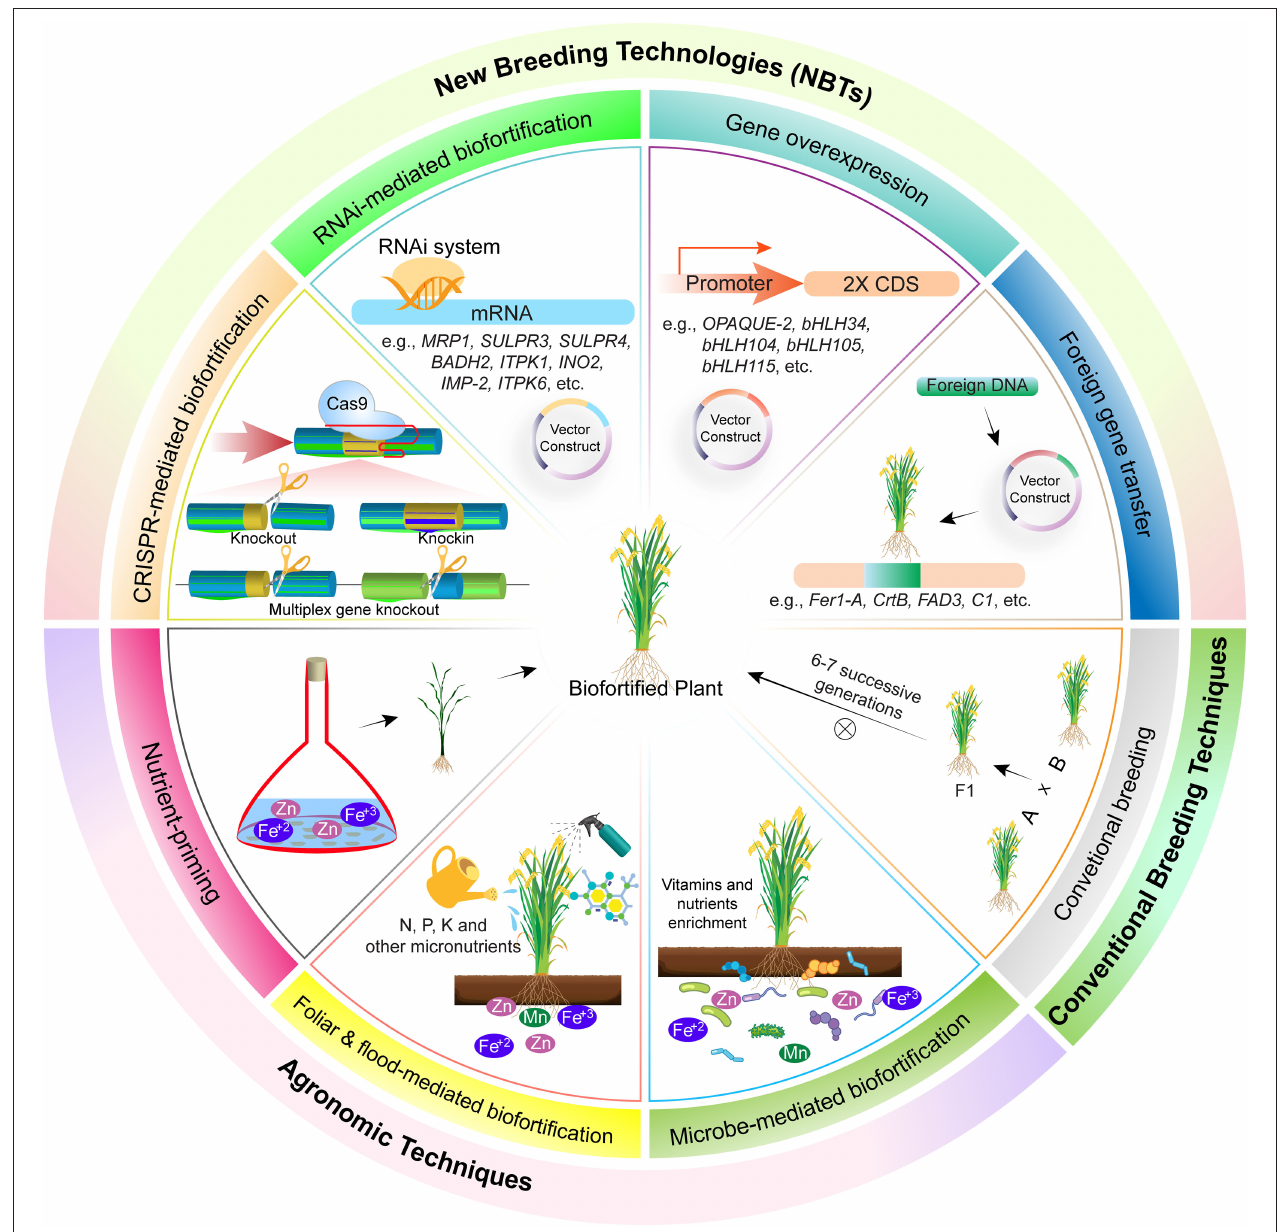
FIGURE 1 | Different methods for biofortification of crops. These are broadly classified into three types, i.e., agronomic techniques, biofortification of crops through foliar spray of micronutrients. Foliar application helps in acquisition of more nutrients in reproductive parts, and hence healthier foods are delivered to the consumer. In this technique, nutrients are applied in liquid form in aerial parts of plants and got absorbed through stomata and epidermis and become part of the food chain. Mineral fertilization through flooding for biofortification of crops. Minerals, i.e., selenium, zinc, calcium, etc., are supplied to crops alongside irrigation and are readily available for uptake and as a result their accumulation in eatable parts of plants is increased. Mineral fertilization through soil application for biofortification of crops. Mineral fertilizers, usually NPK, are applied in the soil bed before sowing or alongside seed using different seed cum fertilizer drills and as a result they are absorbed and made part of the food chain through root uptake. Microbe-mediated enhanced uptake of nutrients for biofortification of crops. Different microbial species, i.e., rhizobium bacteria, mycorrhizae fungi, etc., help plants in nutrient acquisition through mutualism. Conventional breeding helps in biofortification of crops by crossing two parents possessing contrasting phenotypes and selection in subsequent segregation generations based on trait of interest. New breeding techniques, knocking out of genes involved in biosynthesis of anti-nutrient compounds. Different anti-nutrient compounds, i.e., lectins, phytic acid, saponins, lathyrogens, protease inhibitor, α -amylase inhibitors, and tannins restrict bioavailability of essential micronutrients. Hence, this results in malnutriated crops. Genes involved in biosynthesis of anti-nutrients could be repressed through RNAi for reduced accumulation of these compounds. Overexpression of gene responsible for micronutrient accumulation in plants leads toward micronutrient biofortification. Overexpression of genes leads toward increased micronutrients accumulation and, as a result, more deposition in the eatable plant parts. Biofortification of crops through gene transfer from other species has resulted in improvement of nutritional quality of crops and alleviation of